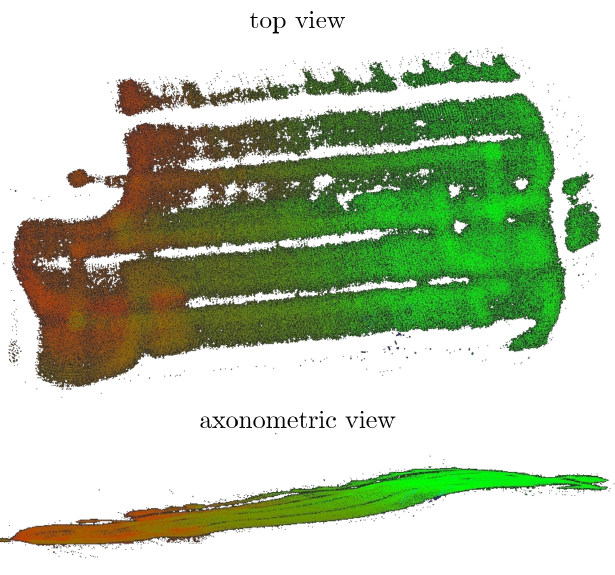
Figure 7. A point cloud of the sea bottom generated from altimeter and FLS measurements. Red points are around 11–12 m deep; in contrast, green points are 8–9 m